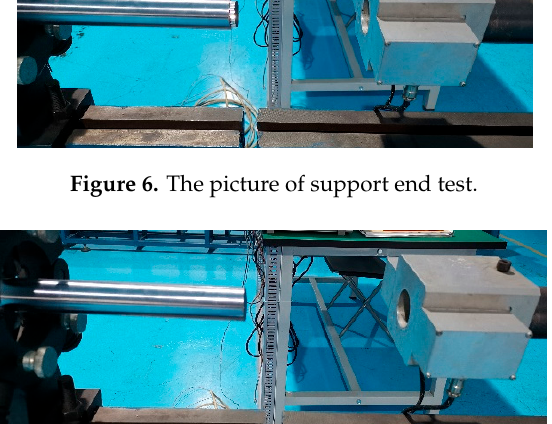
Figure 7. The picture of impact end test.